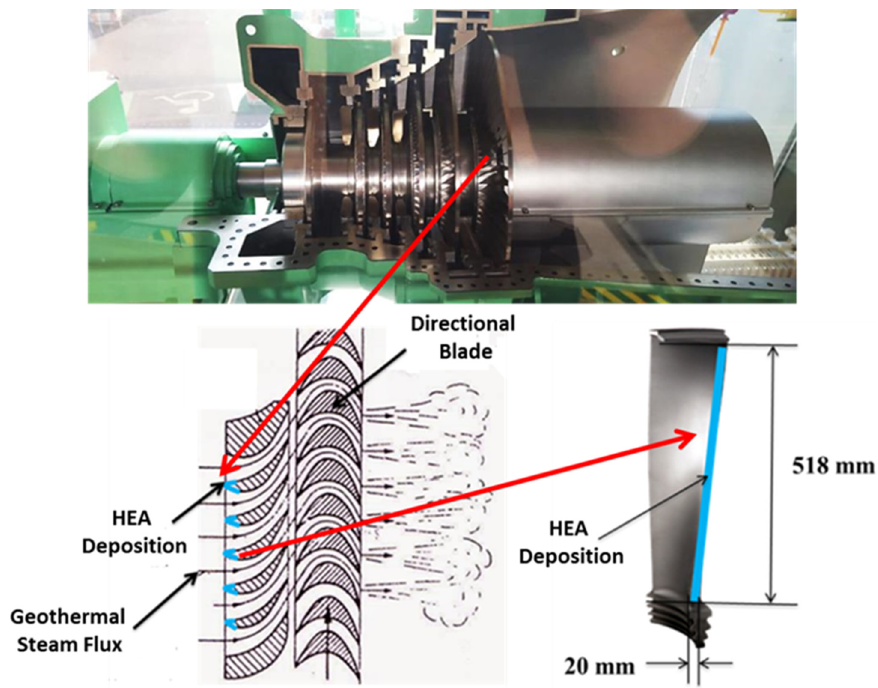
Figure 4 . Proposed area and dimensions for the leading edge of the geothermal turbine blades